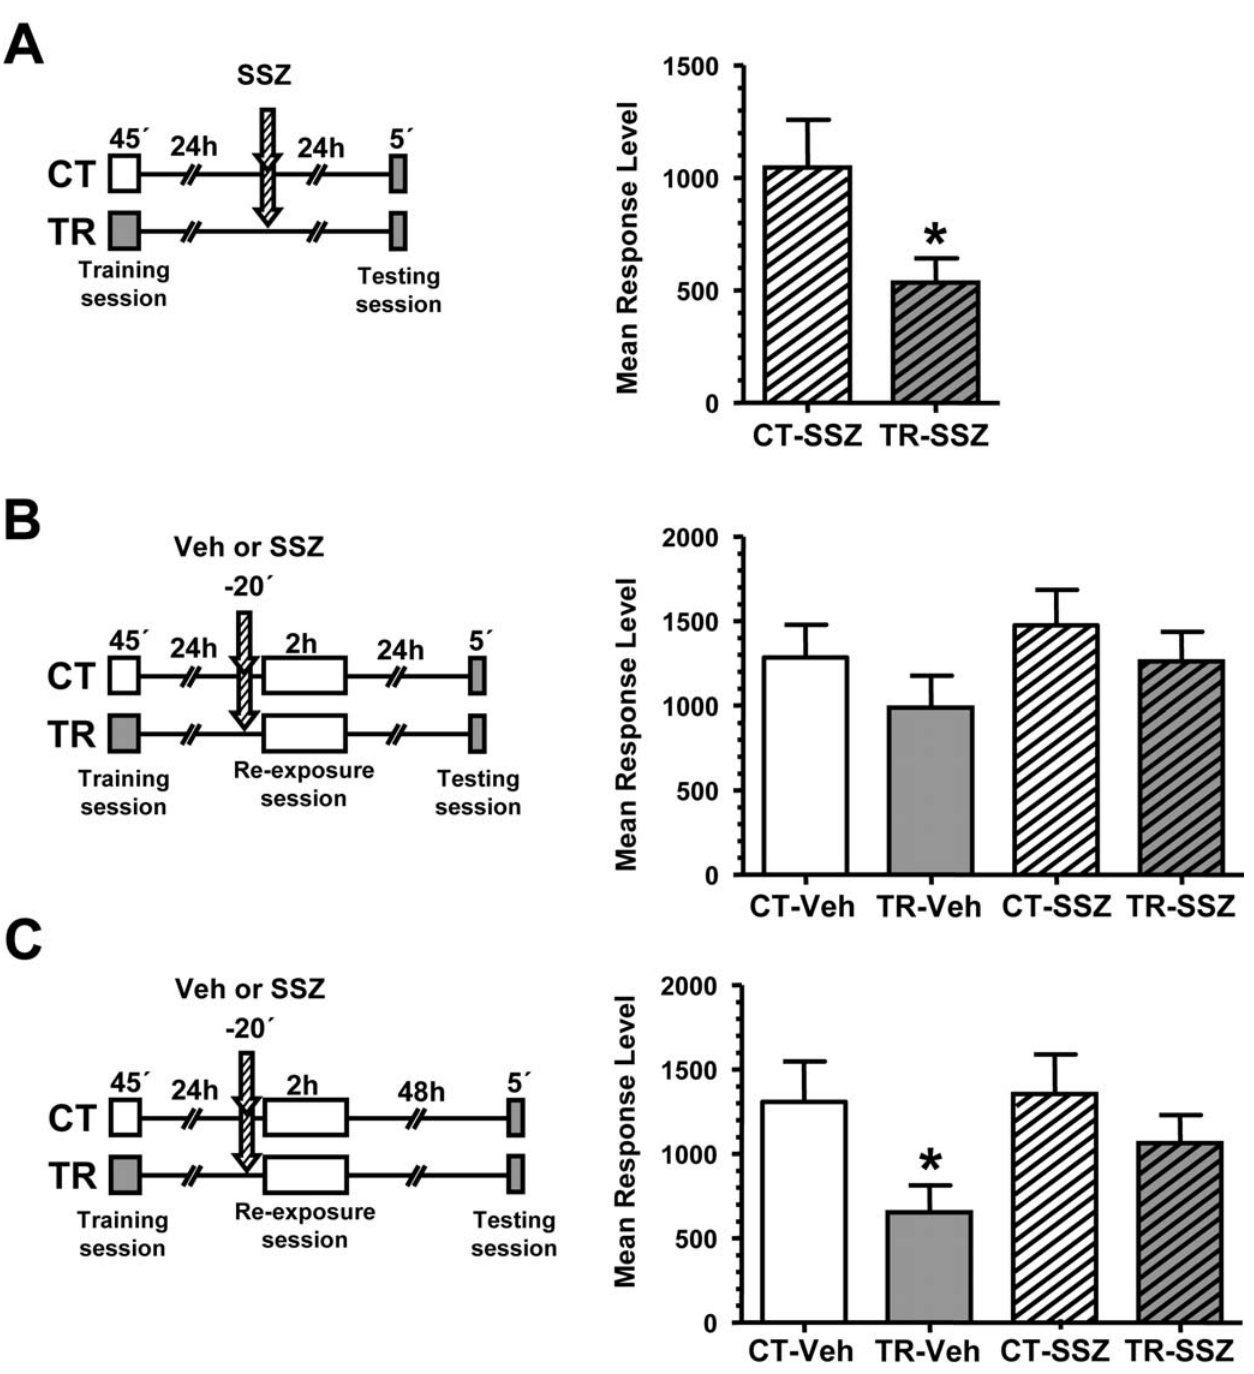
Figure 1. Effect of sulfasalazine on memory extinction. A. Effect of sulfasalazine injection 24 h after training without re-exposure session. Left panel : Experimental design. On day 1 the animals were trained with 15 trials (TR groups) or were located in the training apparatus but remained untrained (CT groups). On day two, the animals were injected with 6 m g/g sulfasalazine (indicated with arrows). 24 h after the injection the animals were tested for memory retention with one trial in the training context. Right graph: Performance at testing session. B. Effect of sulfasalazine 20 min before prolonged re-exposure session. Left panel : On day 1 the animals were trained with 15 trials (TR groups) or were located in the actometers but remained untrained (CT groups). On day two, a pair of CT-TR groups was injected with 6 m g/g sulfasalazine and the other with vehicle solution (indicated with arrows). 20 min later, all groups were re-exposed to the training context for 2 hours. 24 h after the extinction session the groups were tested for memory retention with one trial in the training context. Right graph: Performance at testing session. C. Effect of sulfasalazine in spontaneous recovery. Left panel : the same as in B, but the testing session was given 48 h after the extinction protocol. Right graph: Performance at testing session. Values are Mean Response Level 6 SEM at testing. *, p , 0.05.